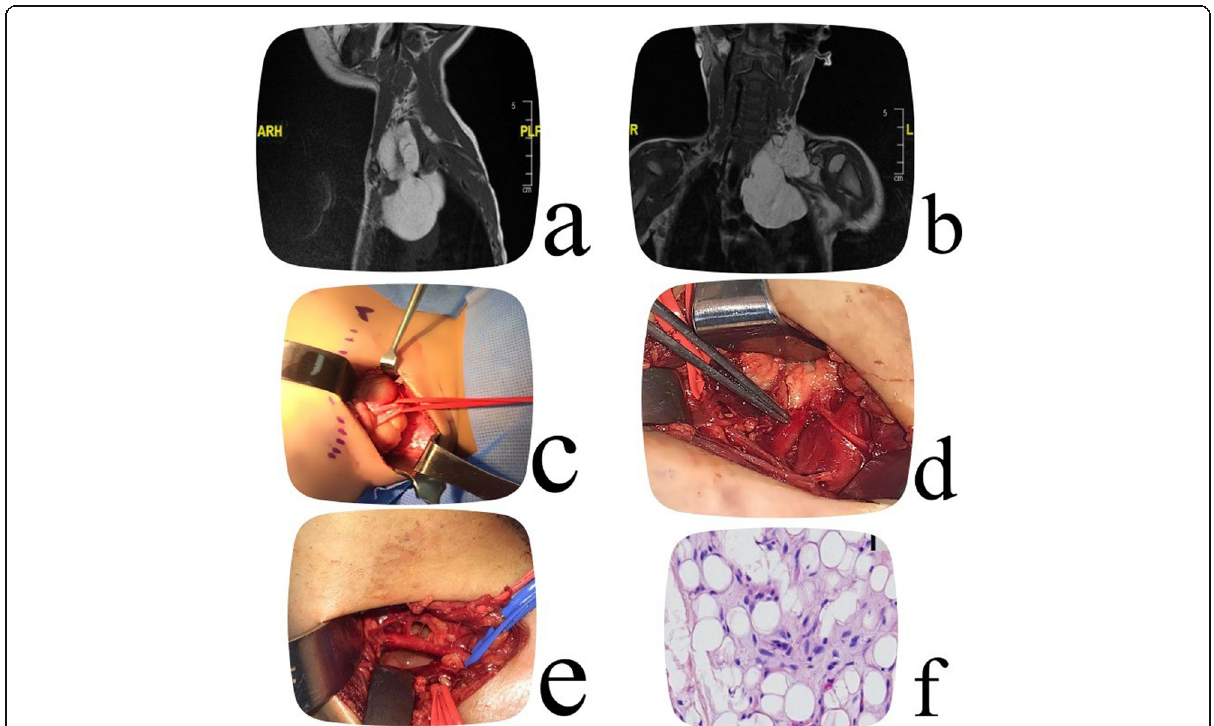
Fig. 2 a , b MRI. c The mass stretching of the brachial plexus (isolated in the vessel loops). d Removing cervical portion exposed the left subclavian vein (pointed to it by the Debakey forceps). e The subclavian artery (blue vessel loop), subclavian vein (lower vessel loop), and the brachial plexus (upper vessel loop) with empty cavity. f Histopathology